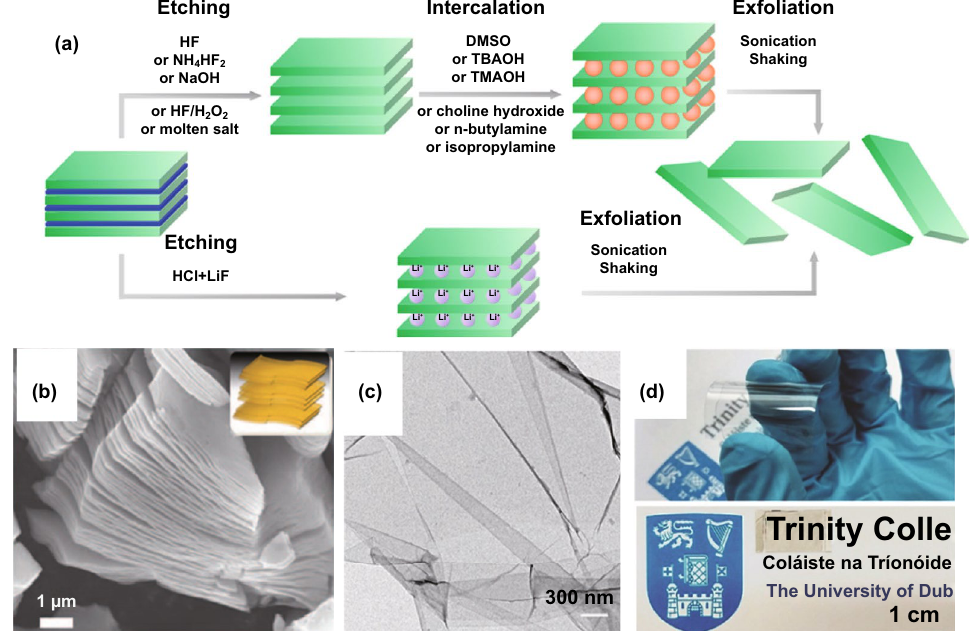
Fig. 6 MXene preparation by chemical exfoliation. a Mechanism of chemical exfoliation. Reproduced with permission from Ref. [56]. Copy- right 2019, Elsevier. b SEM image of intercalated procure. Reproduced with permission from Ref. [57]. Copyright 2013, The American Asso- ciation for the Advancement of Science. c TEM image of few-layer MXene. Reproduced with permission from Ref. [58]. Copyright 2014, Royal Society of Chemistry. d Digital image of MXene-based transparent electrode. Reproduced with permission from Ref. [59]. Copyright 2017,